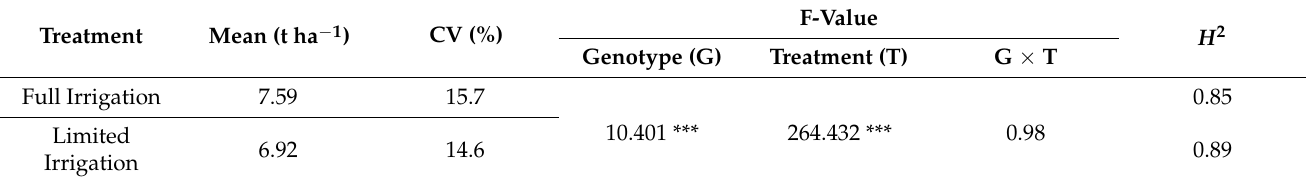
Table A1. Main statistical parameters of grain yield under two irrigation treatments.